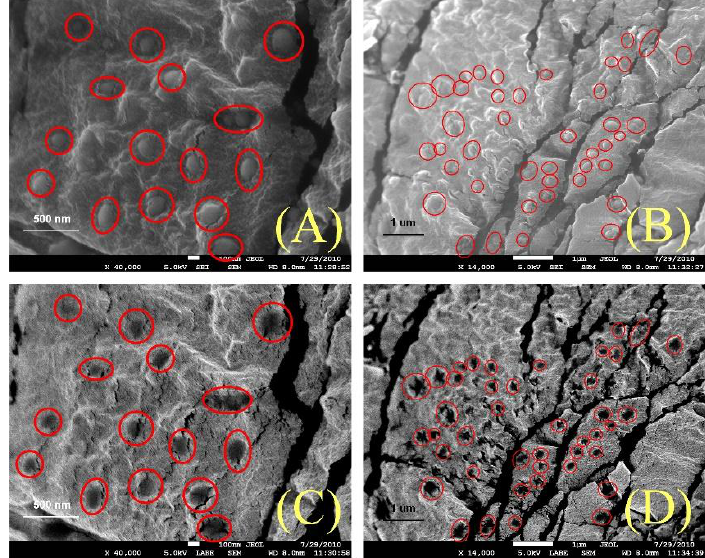
Figure 8. SEM images of the nanofluid (1 wt % nanoparticles and 5 wt % GA): secondary electron images ( A , B ) and backscatter images ( C , D ). The red circles indicate the single compressed liquid layer.